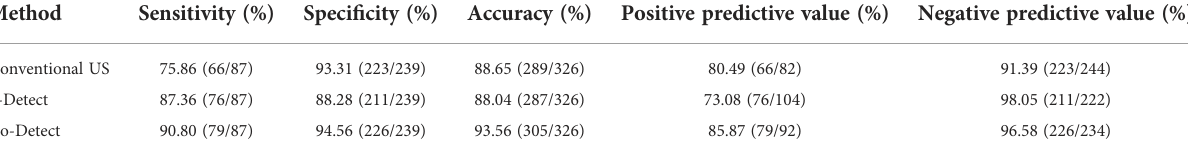
TABLE 3 Ef fi cacy comparison of different methods in diagnosis.